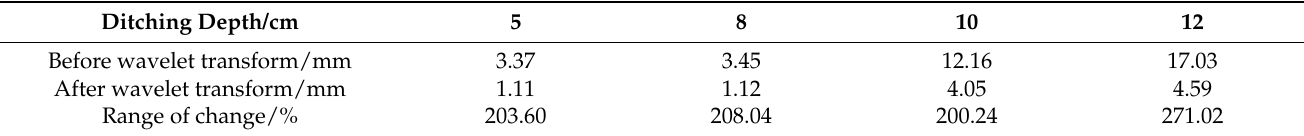
Table 1. Comparison of RMSH values of different ditching depths before and after wavelet processing.